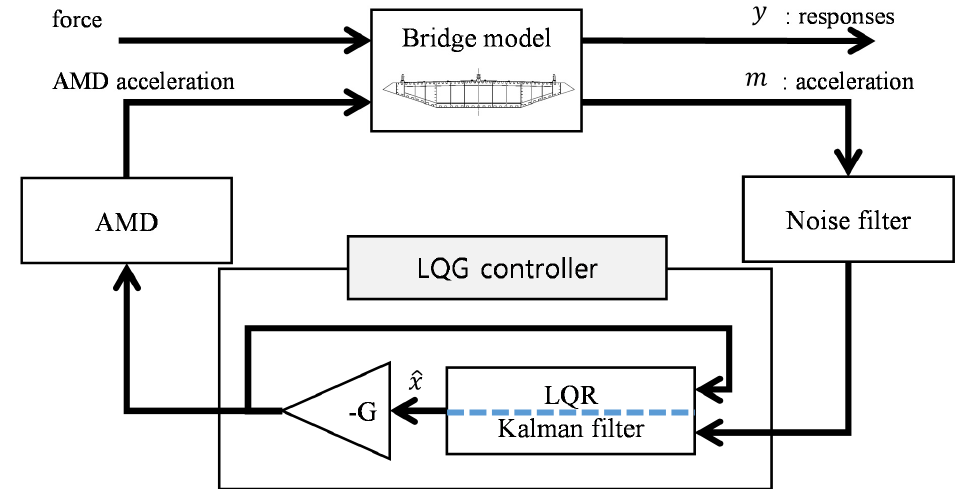
Figure 1. Block diagram of the linear quadratic Gaussian (LQG) control system.